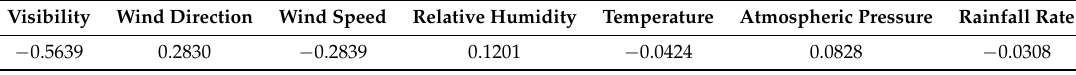
Table 1. Pearson’s linear correlation coefficient between PM 2.5 and meteorological